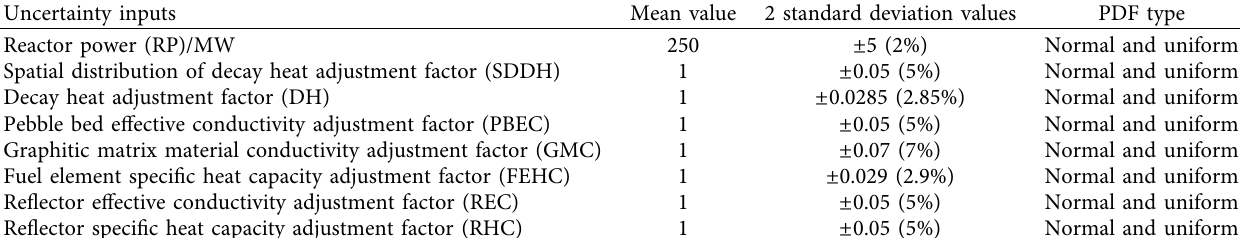
Table 2: Uncertainty information of the eight selected input parameters.